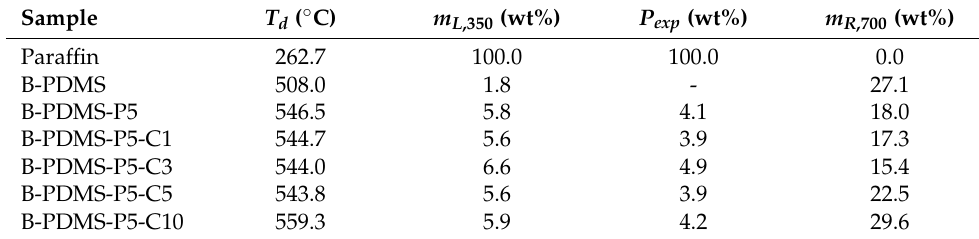
Figure 5. TGA thermograms of some selected compositions (bulk samples). Residual mass and mass loss derivative as a function of temperature. Table 3. Main results of the TGA tests on the prepared bulk samples.